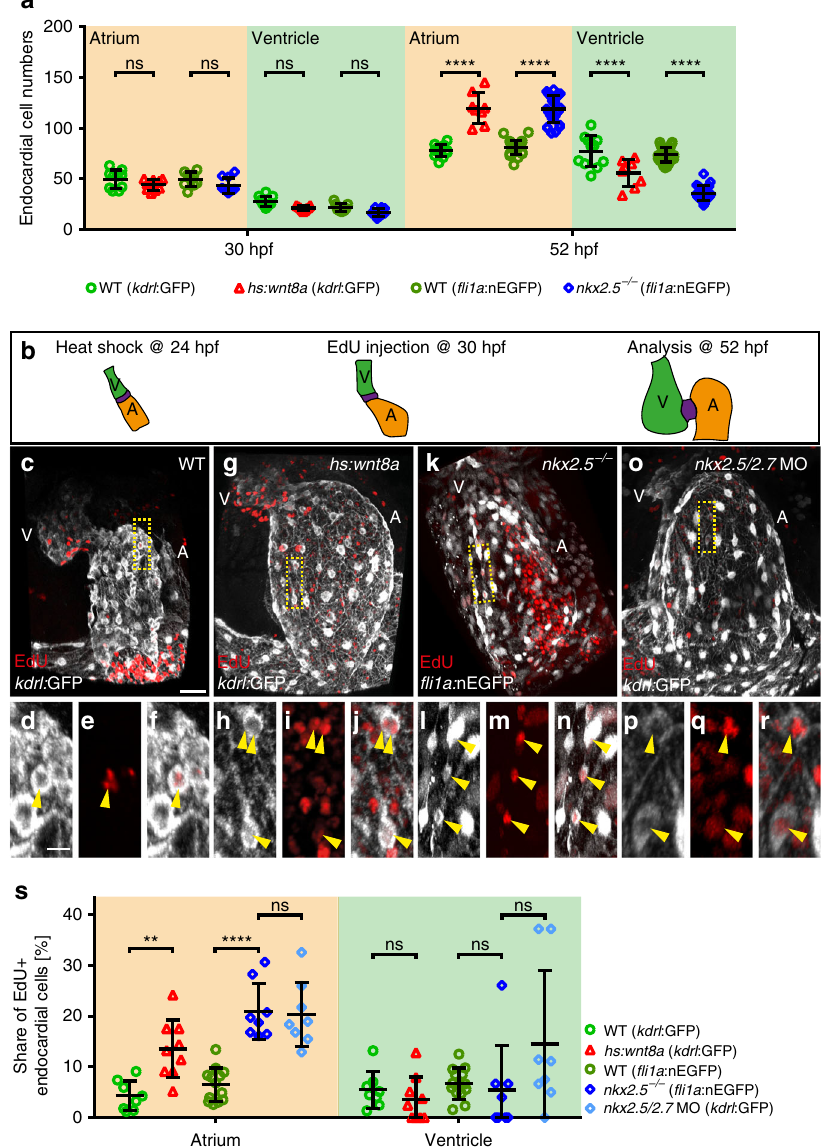
Fig. 2 Atrial endocardial cell proliferation is increased upon Wnt8a overexpression or in nkx2 . 5 vu179 mutants. a Quanti fi cations of endocardial cell numbers at 30 hpf reveals that there is no increase of atrial endocardial cells in Tg(hsp70l:wnt8a-GFP) w34 ( n = 9 hearts), or nkx2 . 5 vu179 mutant embryos ( n = 10 hearts) compared with WT ( kdrl :GFP n = 10 hearts, fl i1a :nEGFP n = 9 hearts) at this stage. At the later heart ballooning stage (52 hpf), a signi fi cant increase of endocardial atrial cell numbers has occurred upon Wnt8a overexpression [ Tg(hsp70l:wnt8a-GFP) w34 ( n = 8 hearts)] or in nkx2 . 5 vu179 mutants ( n = 27 hearts) compared to WT ( kdrl :GFP n = 11 hearts, fl i1a :nEGFP n = 27 hearts). Mean values ± SD are shown. Two-way ANOVA was used to compare each condition with its WT control in each individual chamber (ns: not signi fi cant,**** p < 0.0001). b Schematic model of the EdU assay used. WT and Tg(hsp70l: